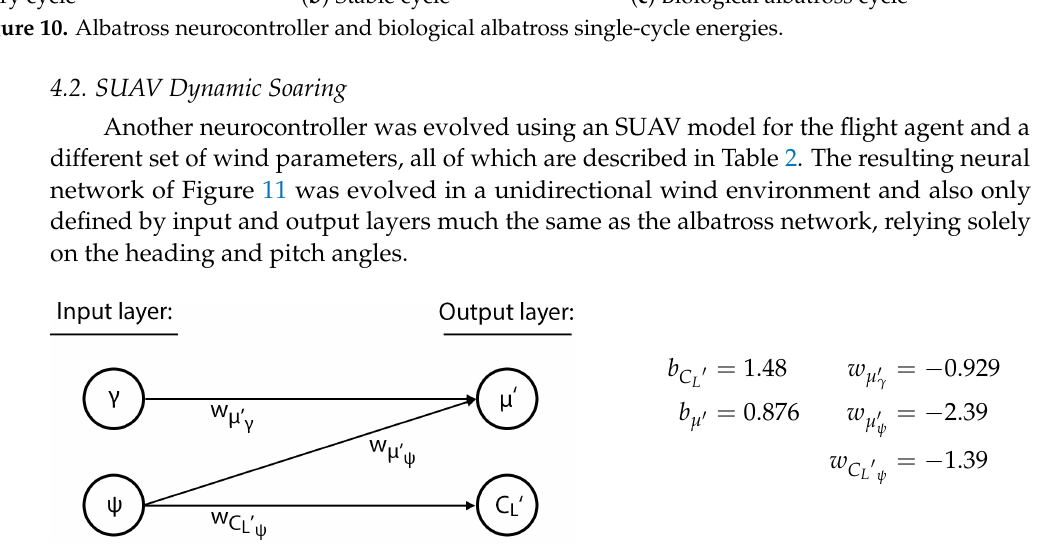
Figure 11. Topology of the dynamic soaring SUAV neurocontroller. Table 2. Dynamic soaring SUAV neurocontroller simulation